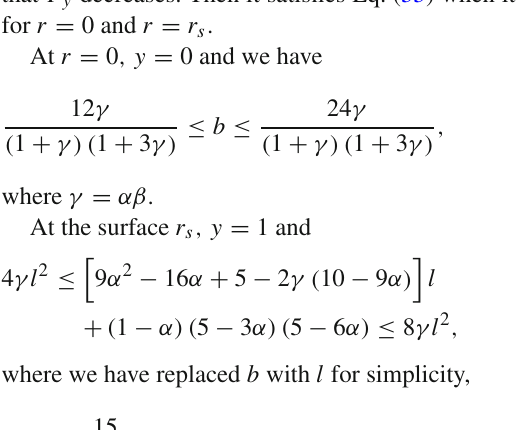
Fig. 1 The decrease of H for the region of Eq. (66)